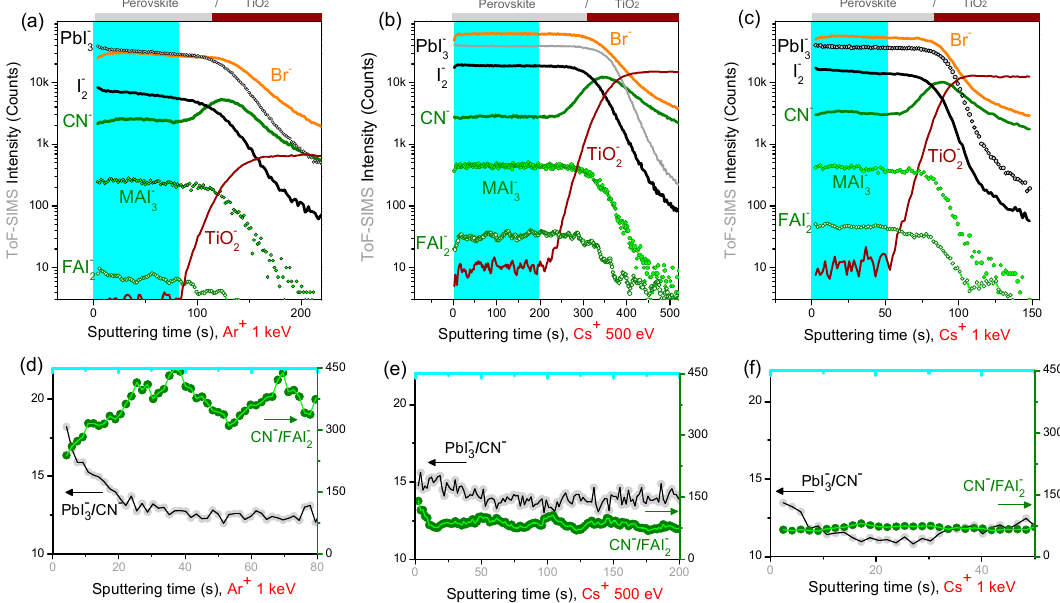
Figure 4. ToF-SIMS depth profiles acquired on Perovskite/cTiO 2 model samples obtained with monoatomic beams. ( a , d ): Ar + at 1 keV; ( b , e ): Cs + at 500 eV; ( c , f ): Cs + at 1 keV. Bottom panels show a selected indicator for the preferential sputtering of inorganic/organic species (PbI 3 − /CN − ) and an indicator for molecular fragmentation (CN − /FAI 2 − ) in the highlighted perovskite region, i.e., before the rise of cTiO 2 − signal. Constant profiles indicate the non-accumulation of damages.